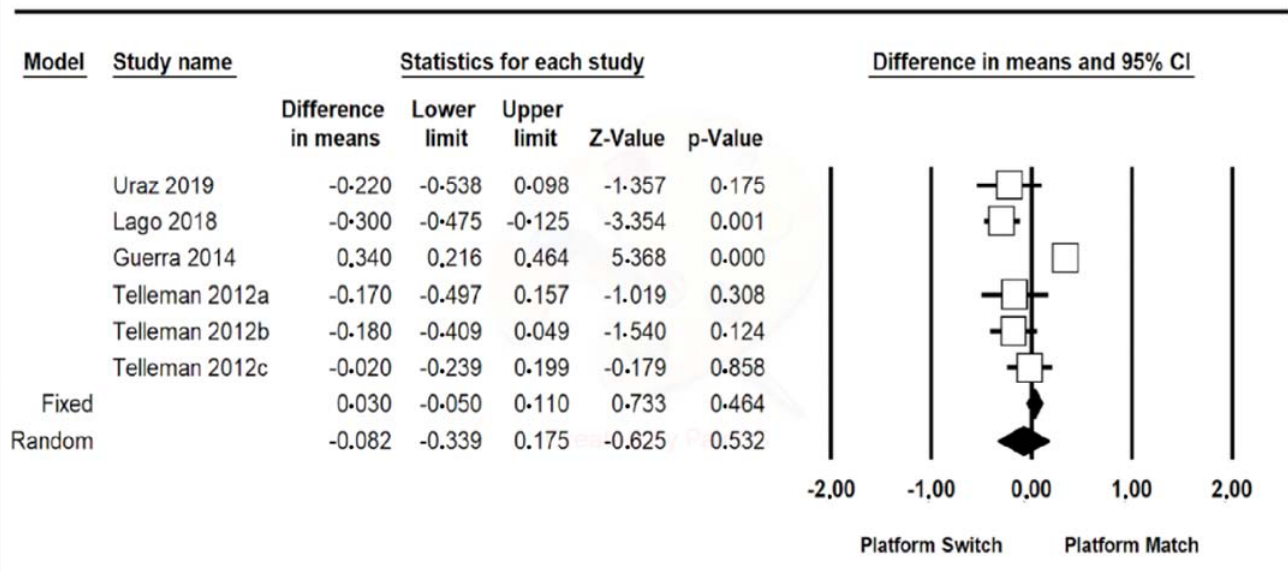
Figure 4. A forest plot increased probing depth.